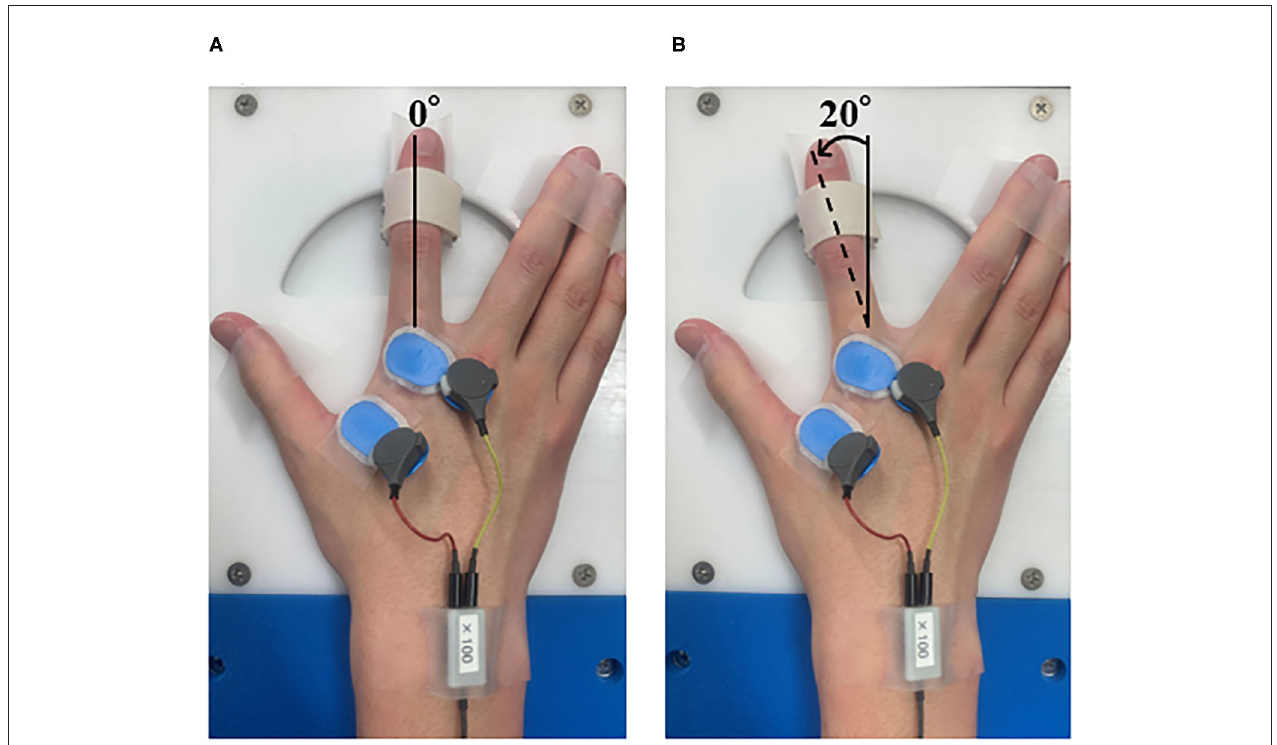
FIGURE 1 | Passive movement intervention. (A) Abduction of the metatarsophalangeal (MP) joint at 0 ◦ . (B) Abduction of the metatarsophalangeal (MP) joint from 0 to 20 ◦ . In the RPM condition, the right index finger was moved passively for 10min. The angular velocity was 40 ◦ /s, the movement frequency was 5Hz, and the movement range was 0–20 ◦ abduction of the metatarsophalangeal (MP)